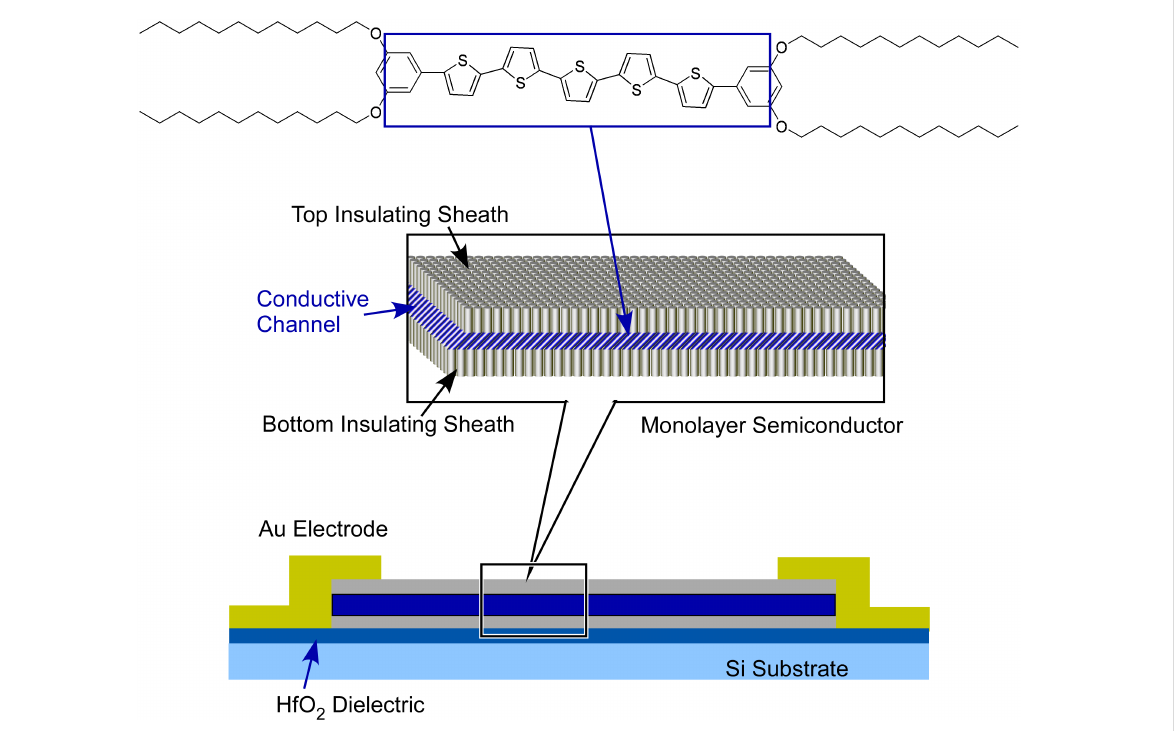
Figure 7: Features of molecular recognition at interfacial media: (i) contacts of phases with different dielectric natures to result in huge enhancement of molecular recognition; (ii) connection of extremely different size events, enabling the manipulation of molecular receptors by macroscopic motion. Adapted with permission from [51] copyright 2015, The Royal Society of